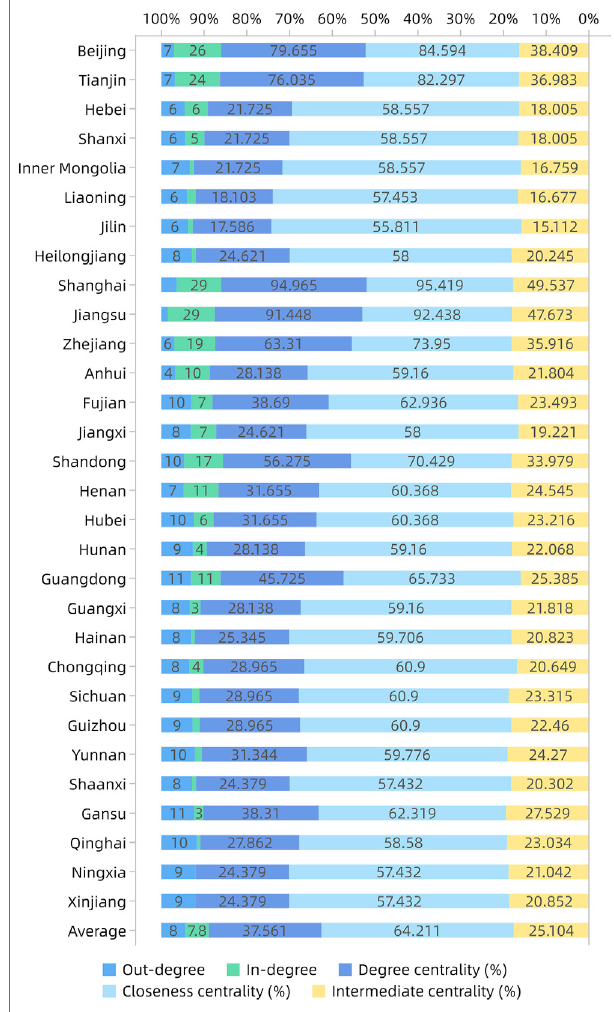
FIGURE4| Centralityofthespatialnetworkoftheinformationentropyof the carbon emission structure in China